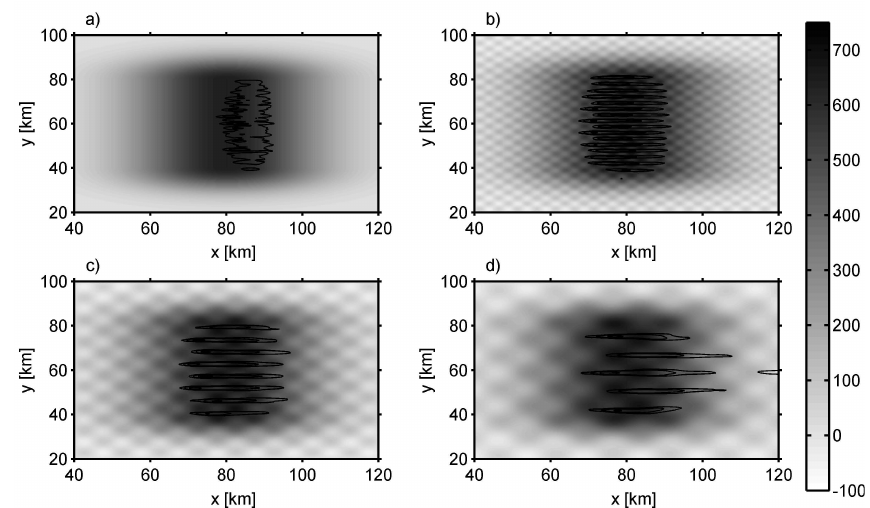
Fig. 2. Horizontal maps of P 5h ac (black isolines at values 1, 10 and 50 mm/5h), and terrain height (gray scale, in m) for simulations (a) CTL, (b) Sst5km, (c) Sst10km and (d) Sst15km.